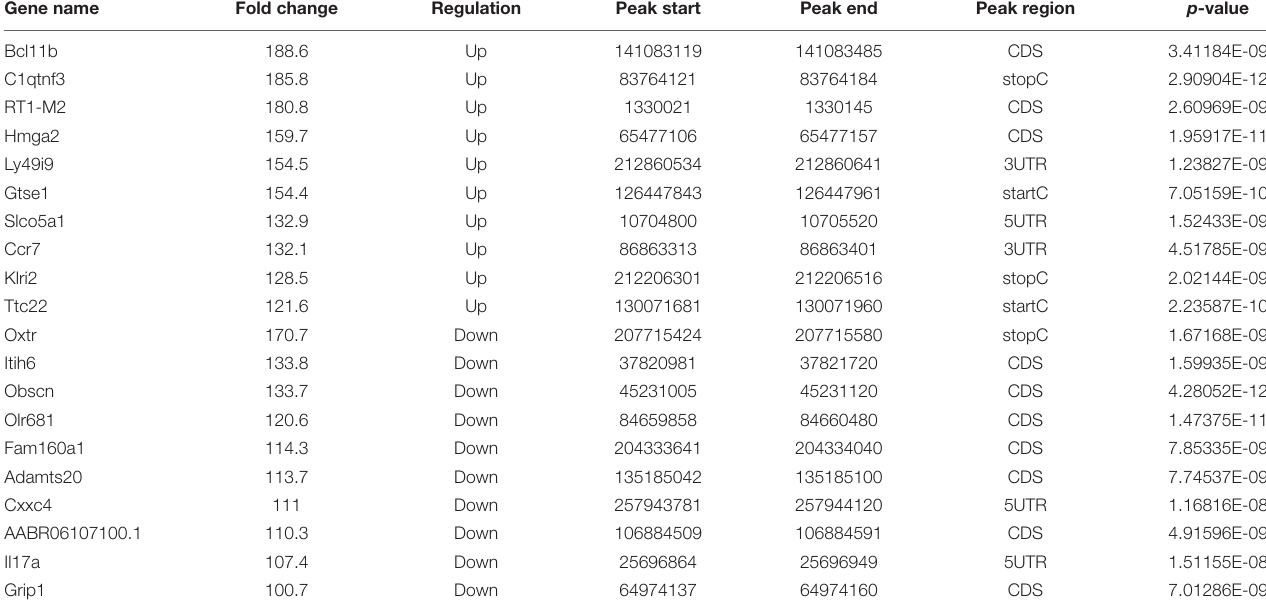
TABLE 2 | The top 20 altered methylated m6A